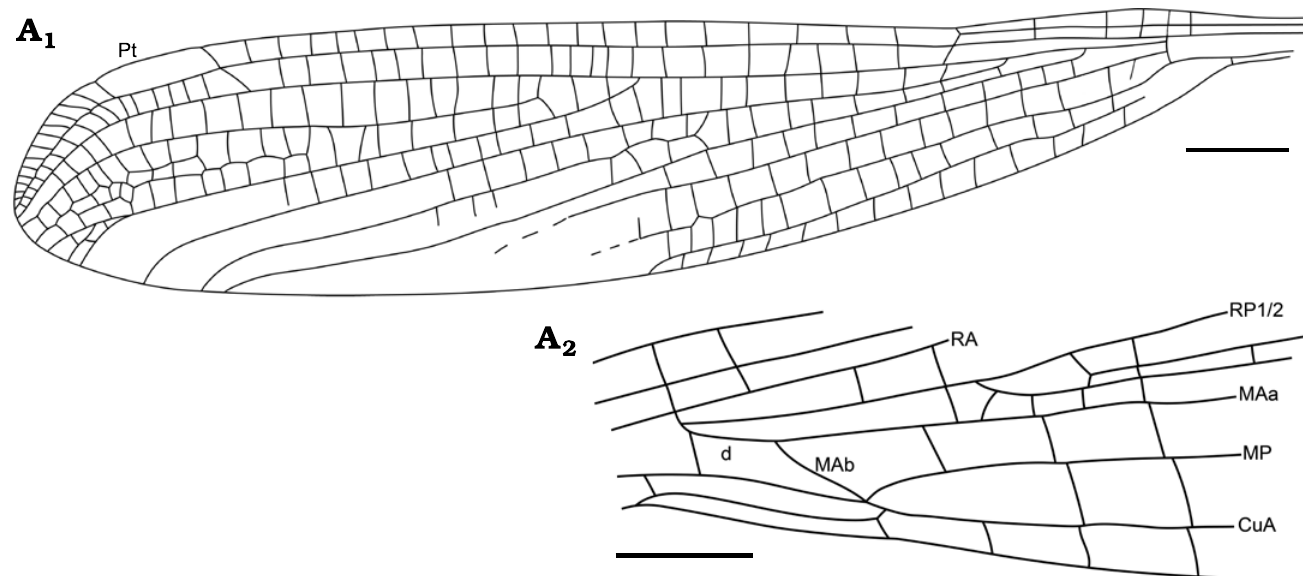
Fig. 10. Zygopteran odonatan Menatlestes palaeocenicus gen. et sp. nov., holotype MNT Nel Odo 2; from Paleocene, Menat, France. Reconstructions. Forewing (A 1 ), hind wing base (A 2 ). Scale bars 1